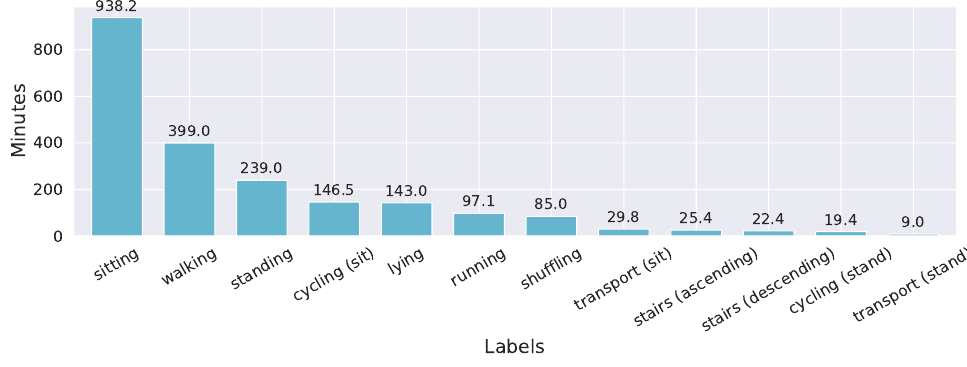
Figure 2. This bar plot shows the total amount of recorded minutes for each activity in the dataset. Figure 3 illustrates ten seconds of back and thigh acceleration of one particular subject. The shaded areas represent the different activities of walking, shuffling, and standing in green, yellow, and gray. It is observable that walking exhibits a repeating pattern in all six axes, corresponding to the participant’s steps. After that, the acceleration stabilizes but is not constant. In particular, the thigh_y and thigh_z axes show small repeating patterns, which are expected during shuffling. Standing shows a nearly constant acceleration in all six